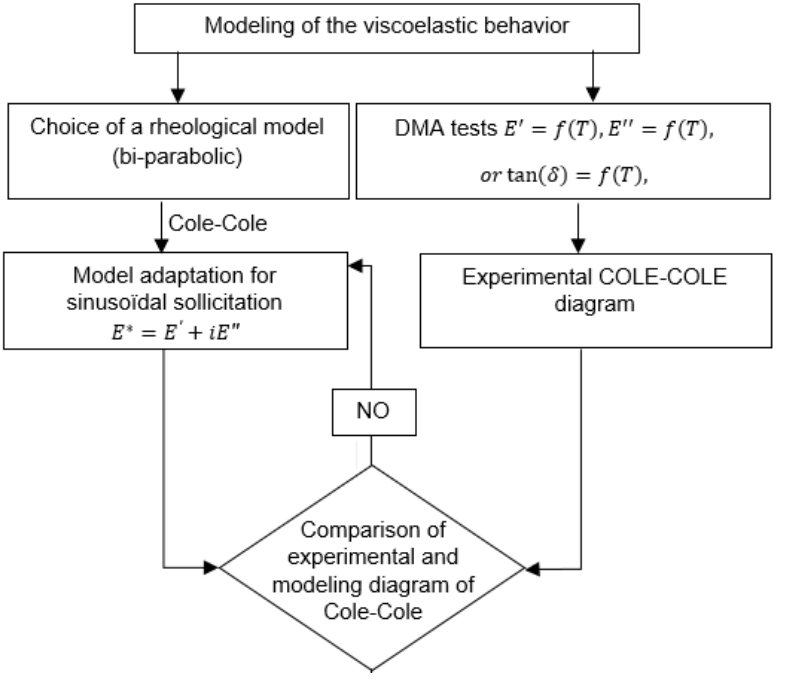
Figure 9. Flowchart diagram indicating the different steps of modeling (𝐸 ∗ : complex modulus, 𝐸 ′′ : loss modulus, 𝐸′ : storage modulus, 𝛿 phase lag between stress and strain).